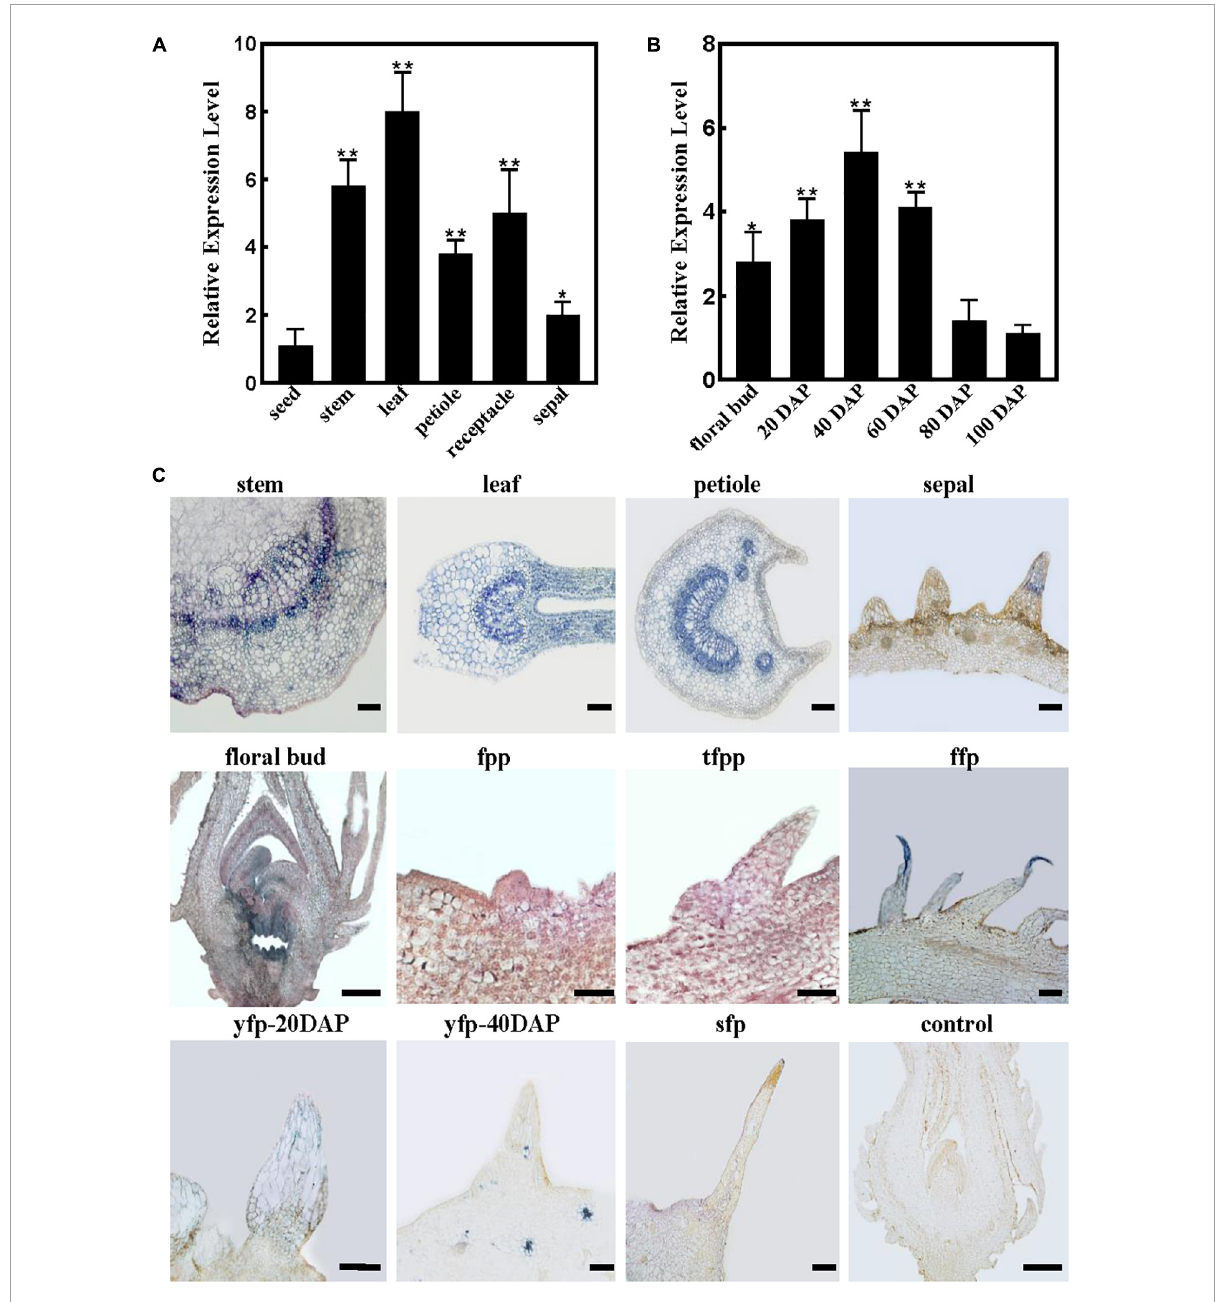
FIGURE3 RrTTG1 was expressed constitutively and highly at the early stage of fruit prickles formation. (A,B) qRT-PCR analysis of RrTTG1 expression in various tissues (A) and fruits at different development stages (B) . Values are presented as means ± SD ( n = 3) and analyzed using one-way ANOVA (** p < 0.01, * p < 0.05). Primers are listed in Supplementary Table 1 . (C) In situ hybridization analysis of the expression pattern of RrTTG1. The expression of RrTTG1 in the young stem, young leaf, petiole, sepal, floral bud, fruit prickle primordium (fpp), triangular-shaped fpp (tfpp), flagelliform fruit prickle (ffp), young fruit prickle on 20 DAP fruit (yfp-20 DAP), 40 DAP fruit (yfp-40 DAP), and 80 DAP fruit (sfp) was detected. The paraffin sections with sense RNA probes of RrTTG1 were used as the control. Bar = 200 µ